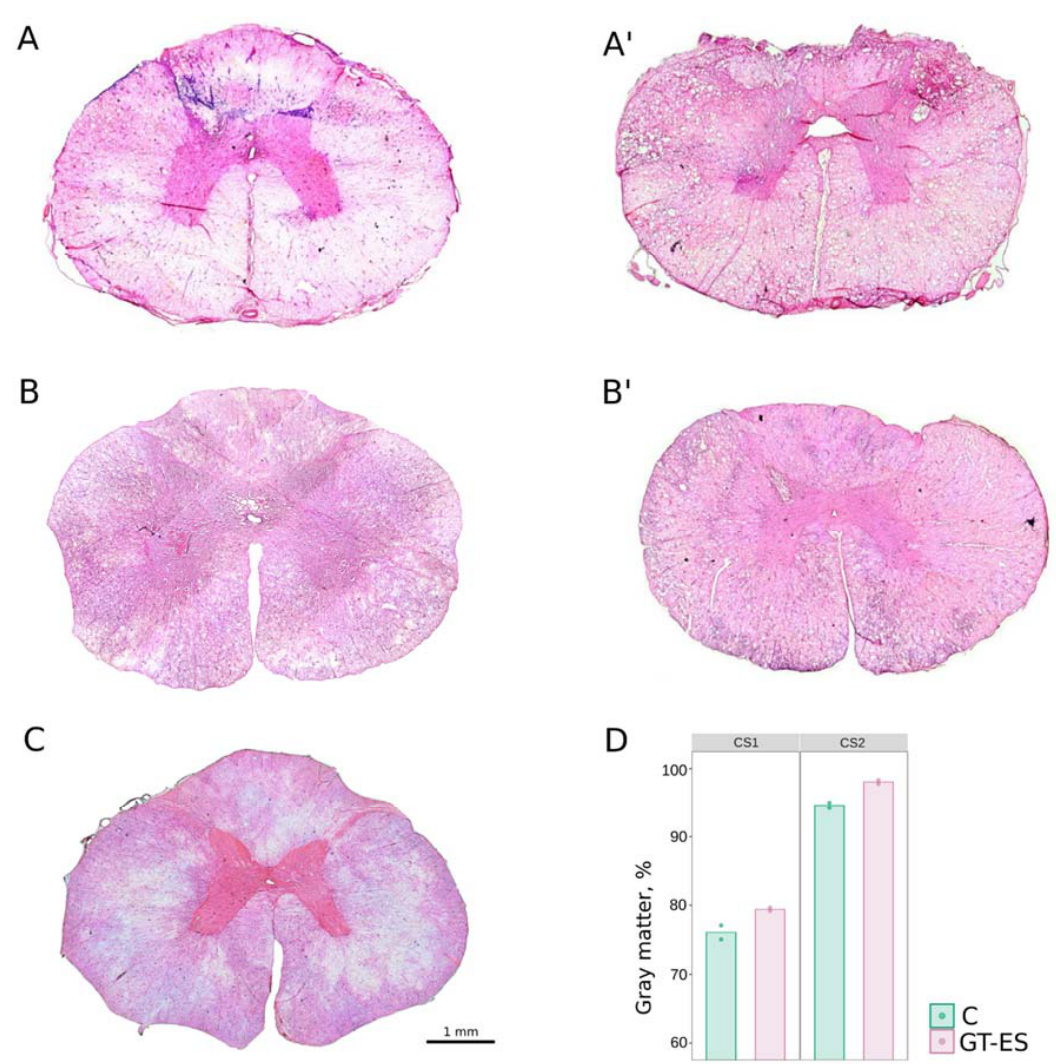
Figure 4. The area of the preserved gray matter in spinal cords at 60 days after SCI in CS1 and CS2 segments. ( A , A ’) Cross sections of spinal cords stained with hematoxylin and eosin in control (C) and treated (GT-ES) animals from CS1. ( B , B ’) Spinal cords of control and treated pigs from CS2. ( C ) An intact spinal cord. ( D ) The relative area of preserved gray matter in control (C) and treated (GT-ES) pigs. Values averaged within animals are presented as points; bars represent group-wise average values.